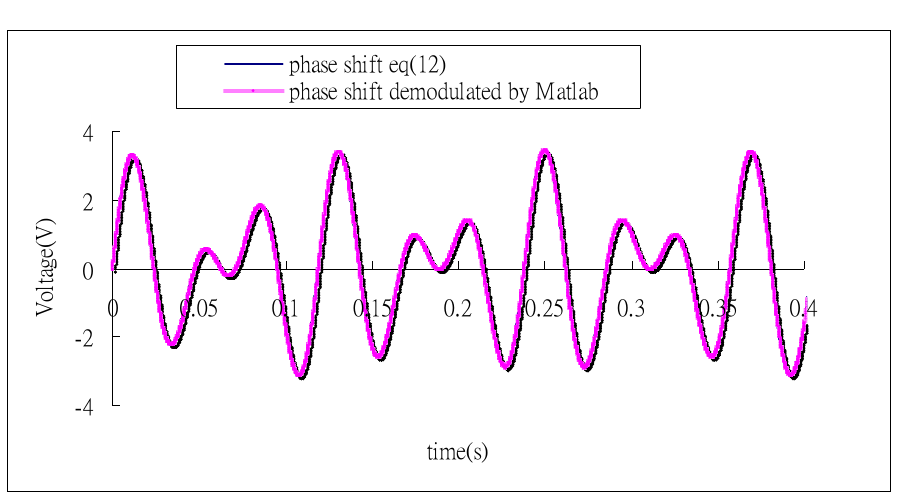
Figure 5. Comparison of the demodulated phase shift and exact phase